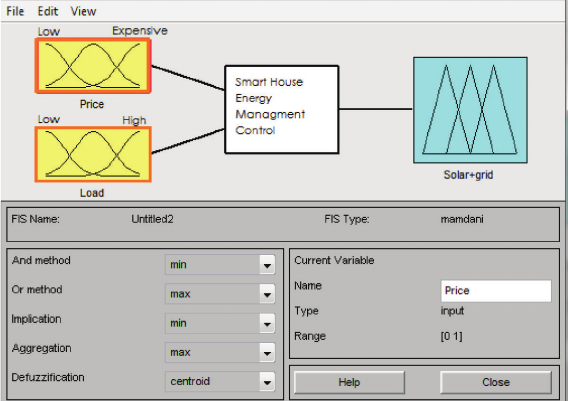
Figure 4: Rules of proposed mamdani’s fuzzy inference system.